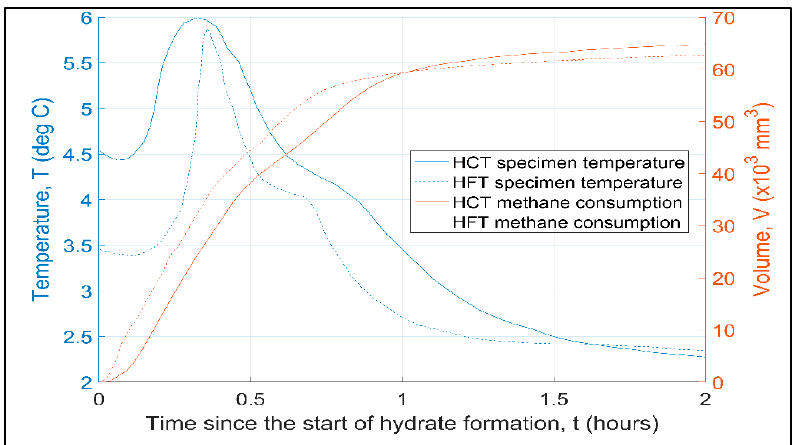
Figure 6. Volume of methane consumed and the change of internal temperature of each hydrate- bearing sand specimen during first two hours of hydrate formation.